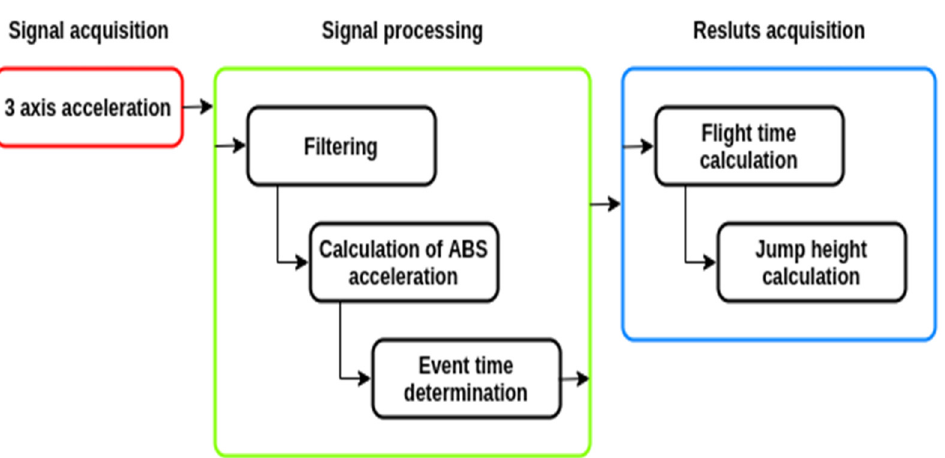
Figure 1. The methodology of JH calculation from IMU data.